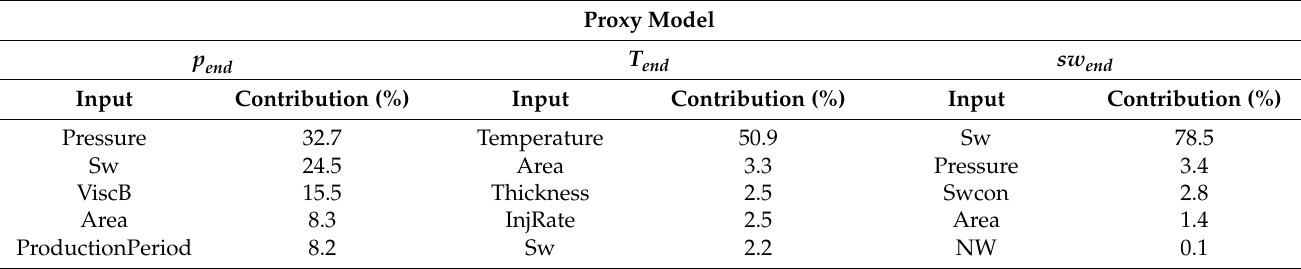
Table 3. Input parameters with the highest contribution towards the output for each proxy model of reservoir conditions after an injection cycle based on Sobol